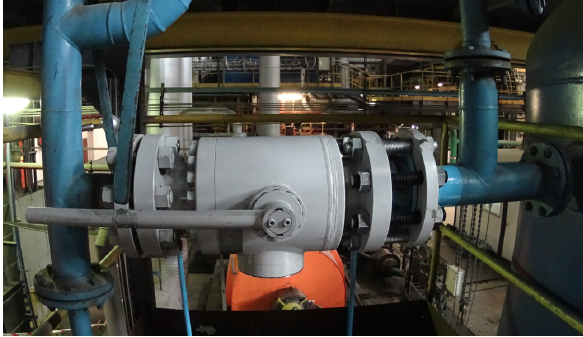
Figure 6: Fragment of the installation with the prototype valve with